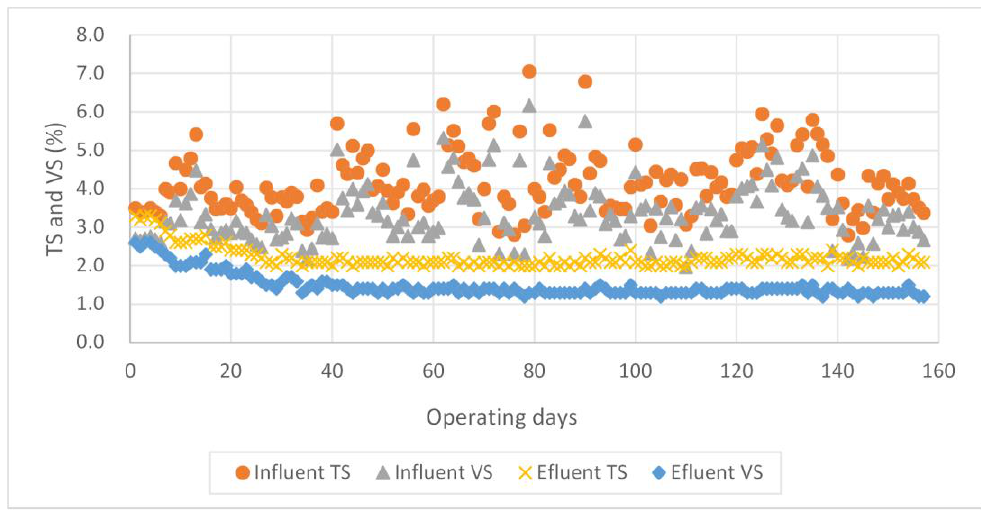
Figure 10. Changes in influent and effluent TS and VS.